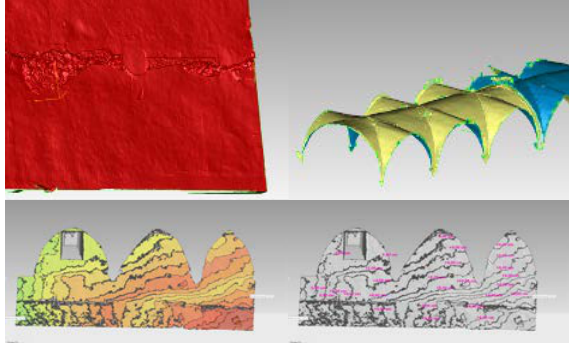
Figure 14. 3D models: mathematical model with mesh surfaces of a wall and the vaults. Map with contour lines that describe the deformations in the wall (software: Geomagic).